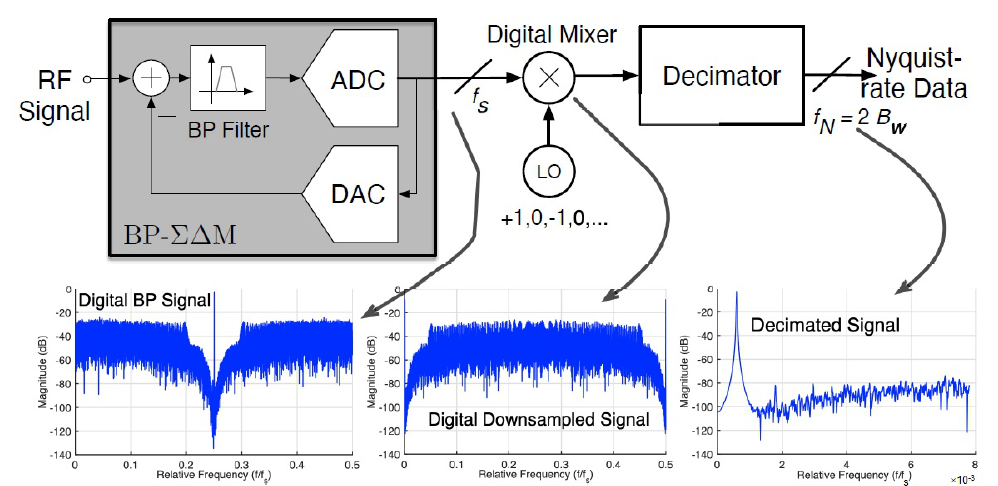
Figure 4. Illustrating the signal processing in a RF Rx based on BP- Σ∆ Ms with f n = f s